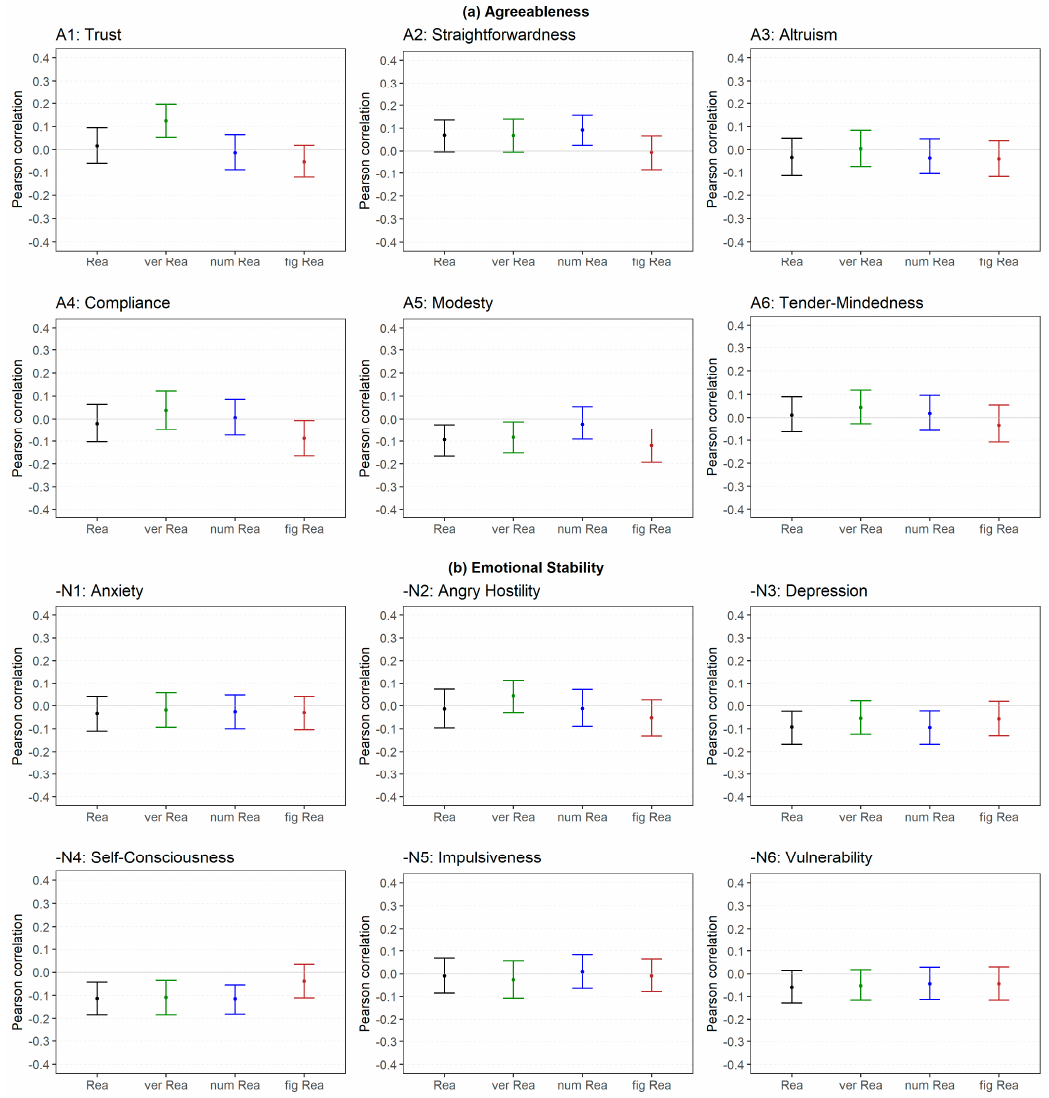
Figure 5. Study 1: Correlations between reasoning and the facets of ( a ) Agreeableness and ( b ) Emotional Stability. Rea = reasoning, ver = verbal, num = numerical, fig = figural.